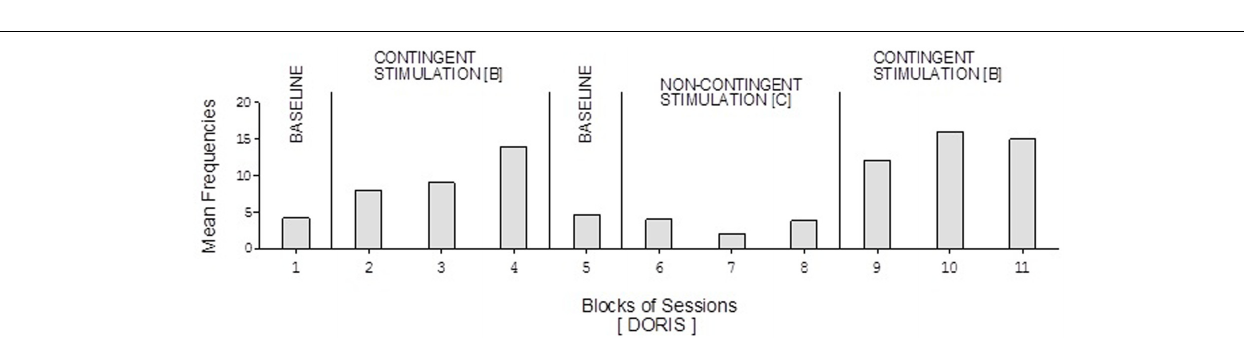
FIGURE 2 | Doris’ data plotted as in Figure 1 with variations on the number of baseline sessions (see